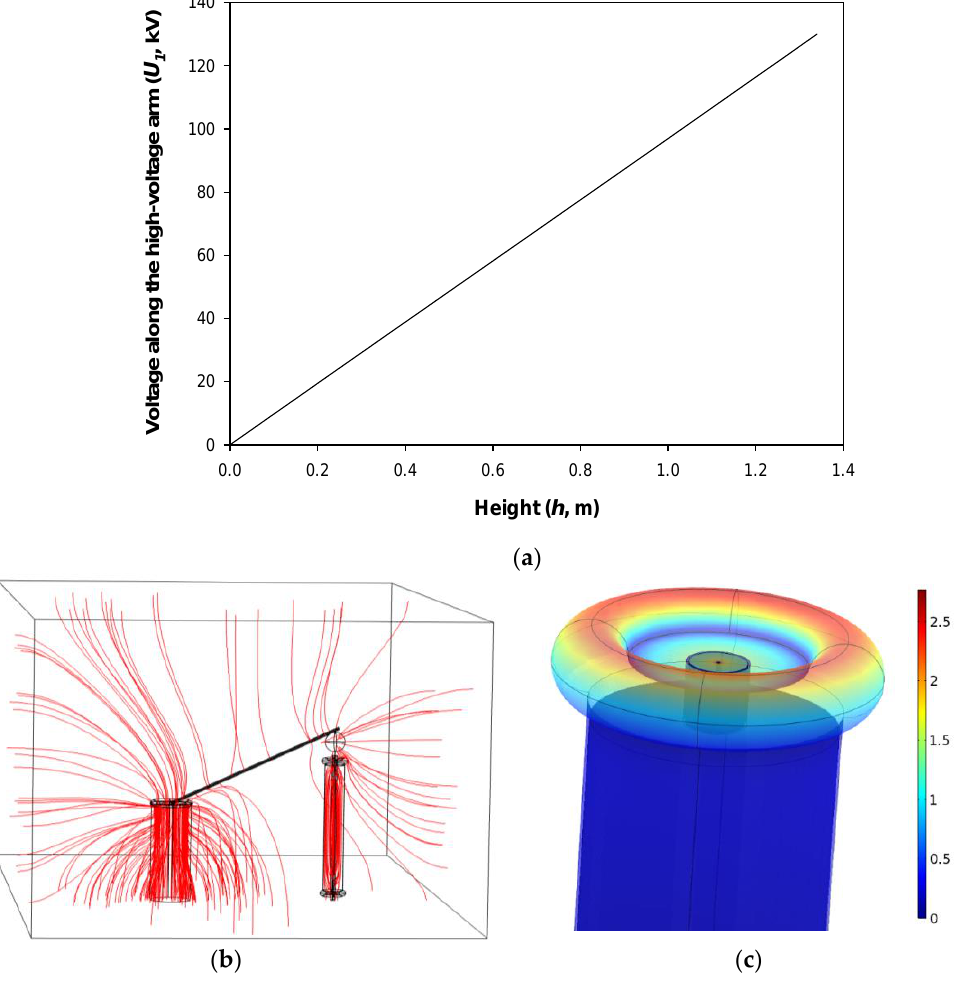
Figure 12. Grading hollow cylinder added to the resistive high-voltage divider to minimize the effects of the stray capacitance. ( a ) Voltage distribution along the high-voltage arm of the divider, ( b ) Streamline plot of the electric field lines around the divider, ( c ) Electric field strength on the surface of the cylindrical protection at 130 kV RMS.